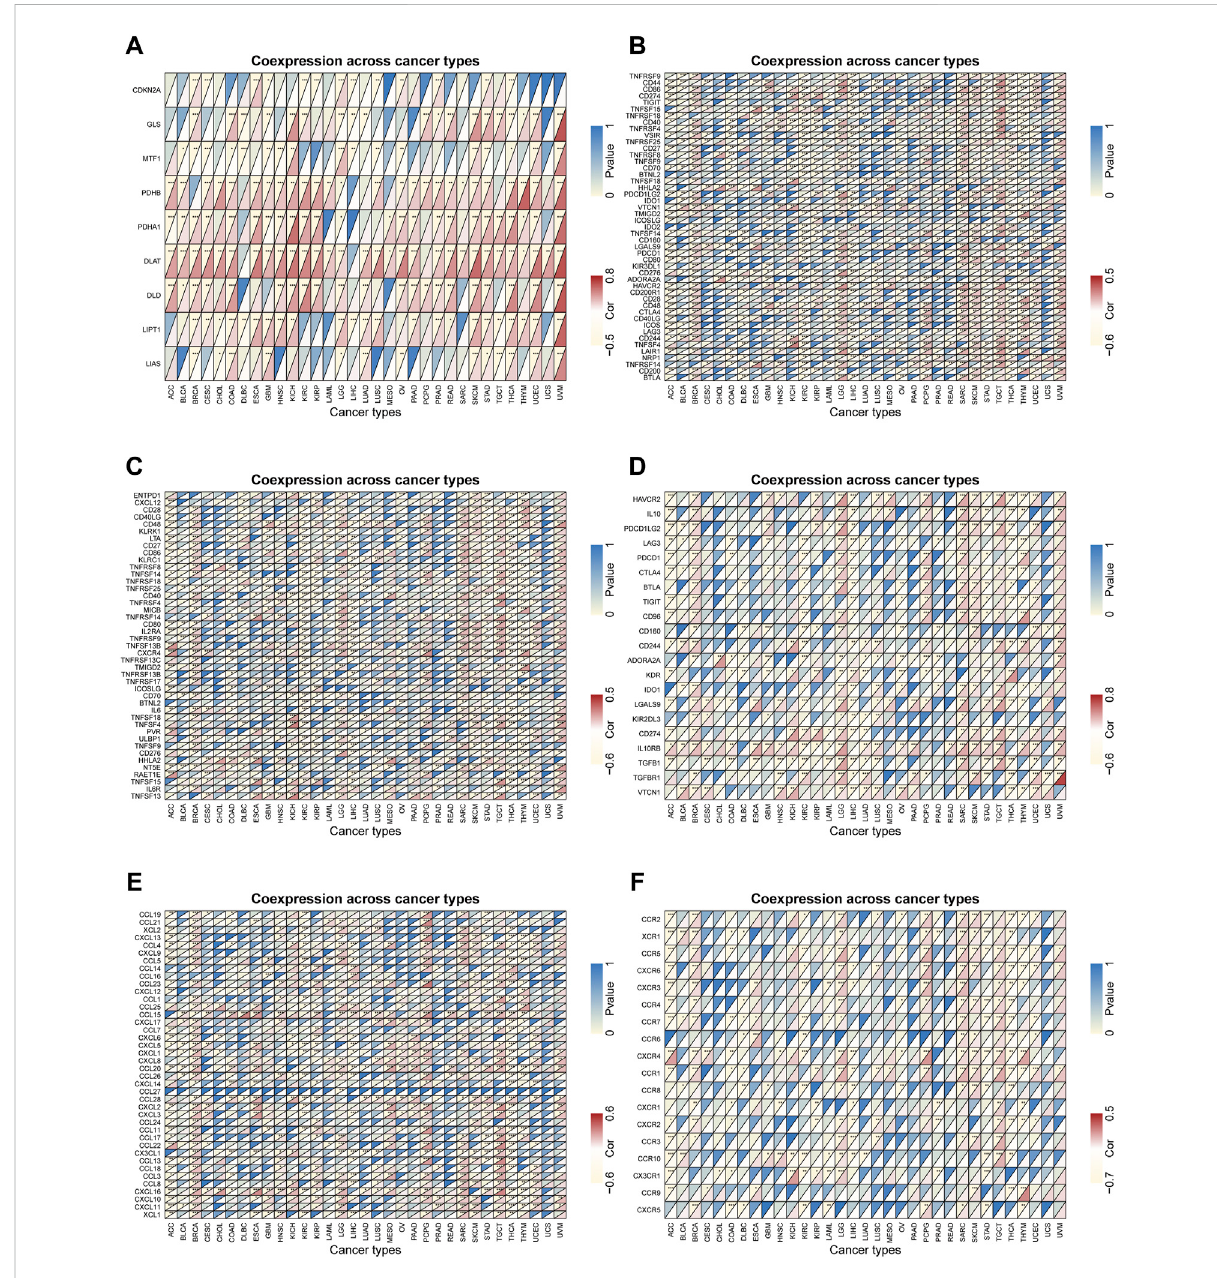
FIGURE 8 Gene co-expression analysis of FDX1 in pan-cancer. The heatmaps presenting the correlations of FDX1 expression with genes related to (A) cuproptosis (B) immune checkpoint (C) immune-activation (D) immunosuppressive status (E) chemokines proteins and (F) chemokine receptors. The upper left corner of each square represents the p value, * represents p < 0.05, ** represent p < 0.01, and *** represent p < 0.001; the lower right corner represents the correlation between FDX1 and other genes, red represents positive correlation, and yellow represents negative